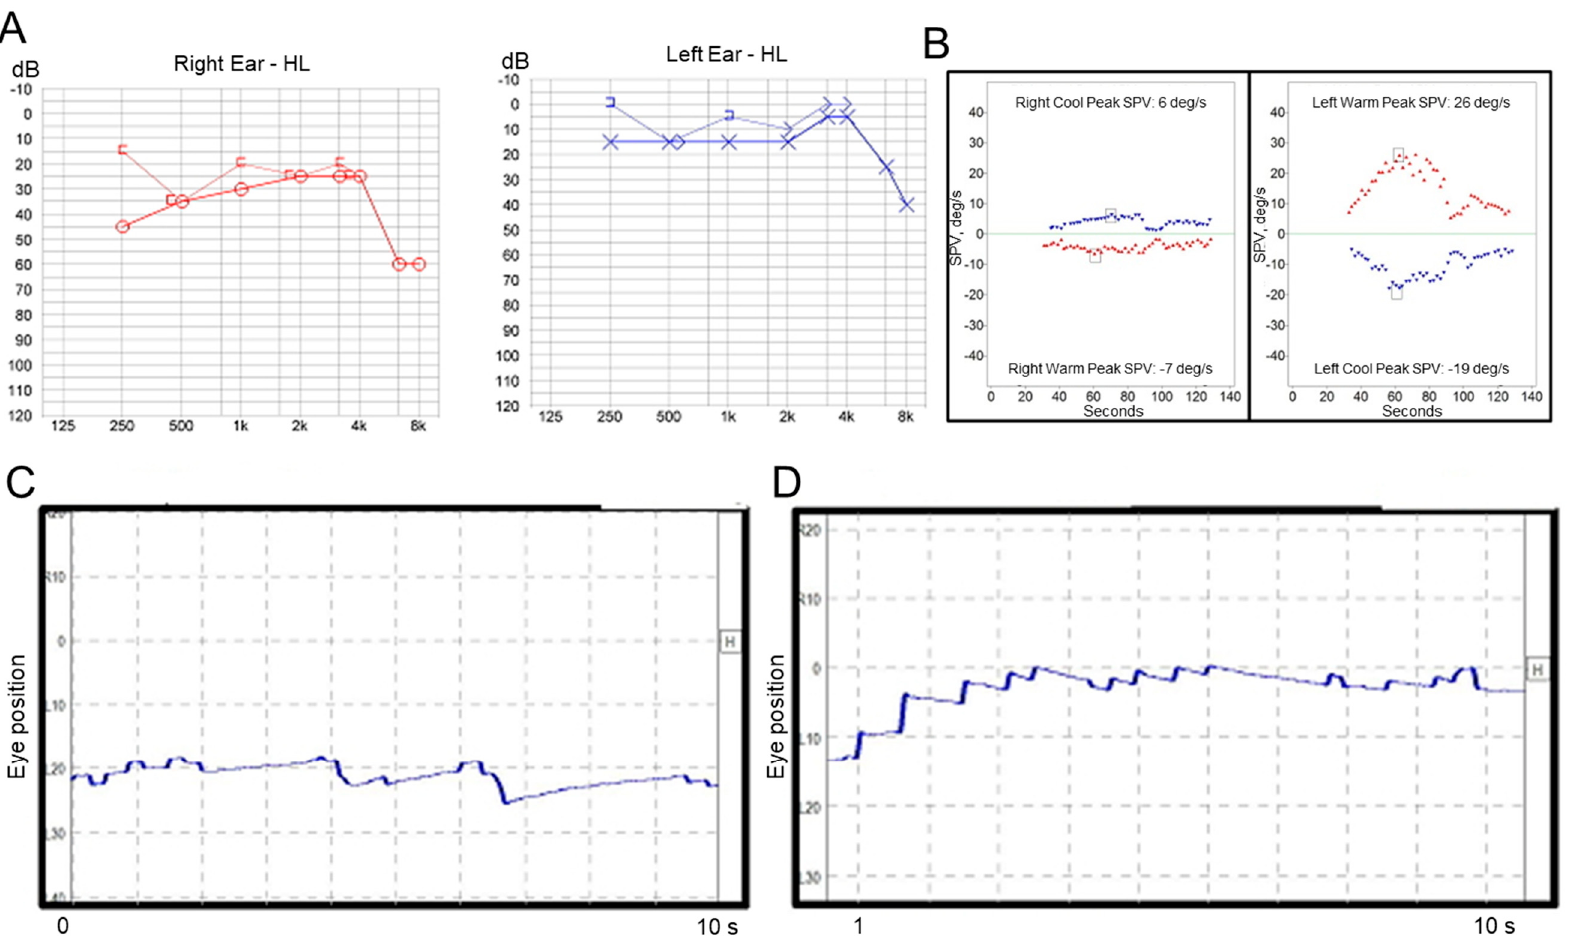
Figure 2. Results of laboratory tests in Case 2. ( A ) Pure tone audiometry shows mild sensorineural hearing loss on the right side. ( B ) A bithermal caloric test reveals canal paresis of 55% on the right side. Video-nystagmography demonstrates very weak left-beating nystagmus in the right head-roll position ( C ), and right-beating nystagmus in the left head-roll position ( D ).